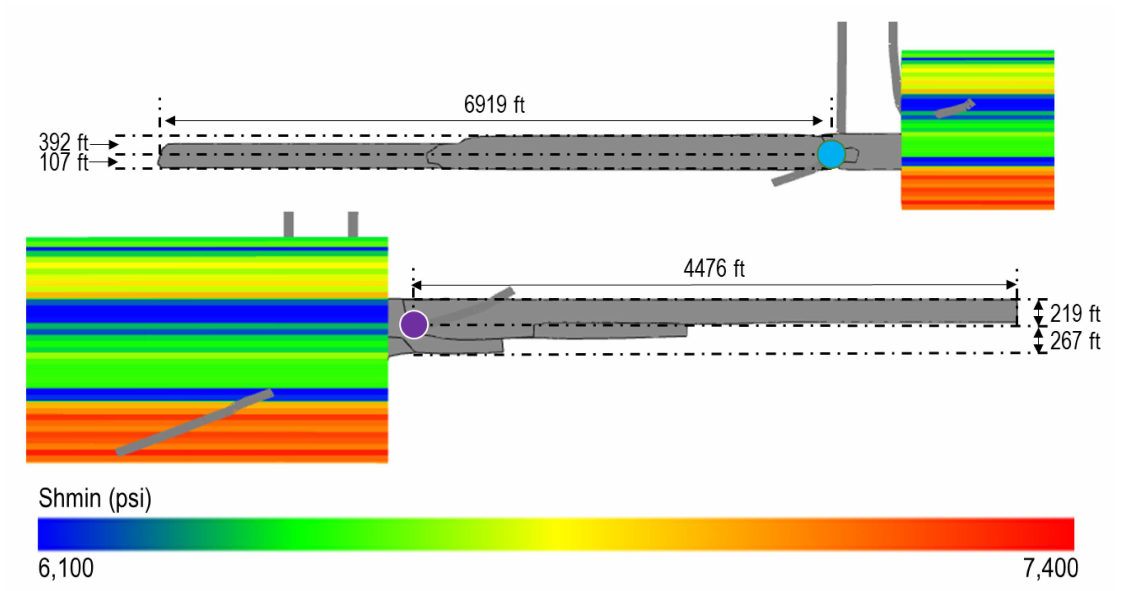
Figure 25. Fracture geometry predicted from numerical simulations for the isotropic stress profile, in bleu Well #1, in purple Well